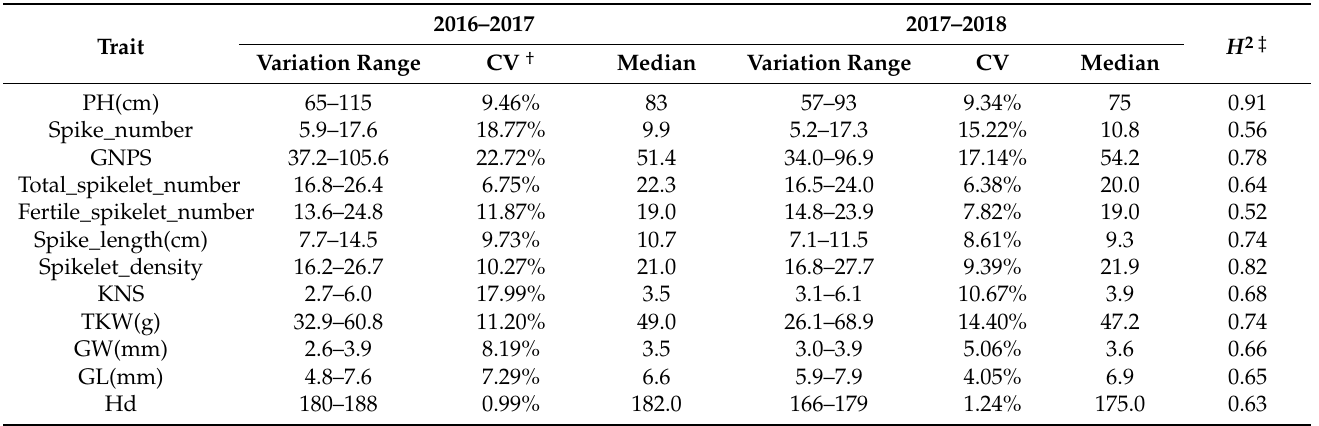
Table 1. Investigation of 12 agronomic traits of 259 lines in 2-year